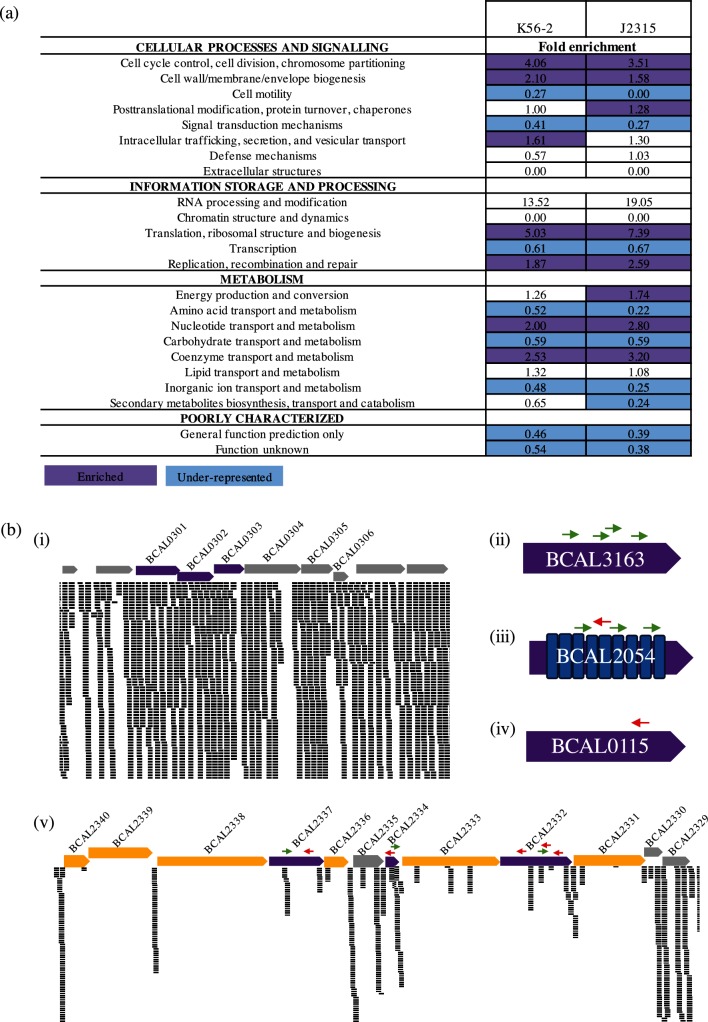
Comparison of the essential gene sets of B. cenocepacia K56-2 and B. cenocepacia J2315. (a) Fold enrichment of COG functional categories for the B. cenocepacia K56-2 and J2315 essential genes. Functional categories significantly enriched (purple) or under-represented (blue) in the essential gene are indicated (P<0.05, Fisher’s exact test). (b) Insertions and corresponding reads mapping to B. cenocepacia K56-2 genes identified as essential in strain J2315 but not in strain K56-2. Arrows represent the orientation of the PrhaB promoter (green, same direction as the ORF; red opposite direction to the ORF). (i) Operon BCAL0301–BCAL0306: BCAL0301, BCAL0302 and BCAL0303 (purple) were identified as essential in strain J2315, but had numerous insertions in strain K56-2. (ii) BCAL3163, encoding a putative nucleotidyltransferase, had four insertions in strain K56-2, all with PrhaB oriented in the same direction as the ORF. (iii) BCAL2054 encodes a protein involved in energy production and conversion that contains multiple phycobilisome (PBS) lyase HEAT-like repeat domains (IPR004155). (iv) Example of possible essential gene containing an insertion that disrupts within the last 35 % of the 3′ end of BCAL0115, encoding a 30S ribosomal protein S21. Only one transposon mutant was recovered containing the insertion disrupting the last 22 % of the 3′ end of the ORF. (v) Operon BCAL2340–BCAL2329 :  three genes were not identified as essential in either K56-2 or J2315 (grey), six were identified as essential in both K56-2 and J2315 (yellow), while three were identified as essential in J2315 only (purple). BCAL2332 has inserts disrupting the proton-conducting membrane transporter domain (PF00361). BCAL2334 has one insert with PrhaB in the same orientation as the ORF, and one insert disrupting the last 32 % of the 3′end with PrhaB in the opposite orientation of the gene. BCAL2337 had one insert disrupting 13 % of the 3′end with PrhaB in the opposite orientation of the gene and inserts disrupting 33 % from the 5′ end with PrhaB in the correct orientation for gene expression.